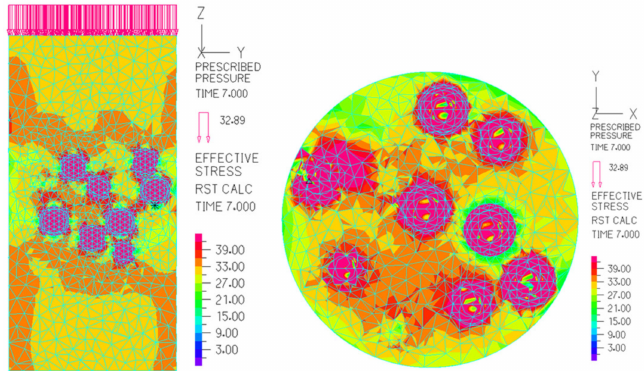
Figure 22. The internal stress diagram of CS concrete